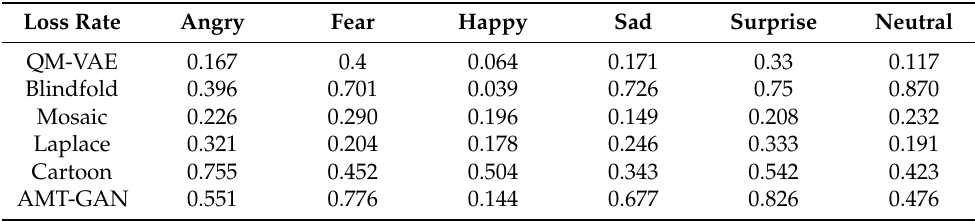
Table 3. Facial expression loss rate under different